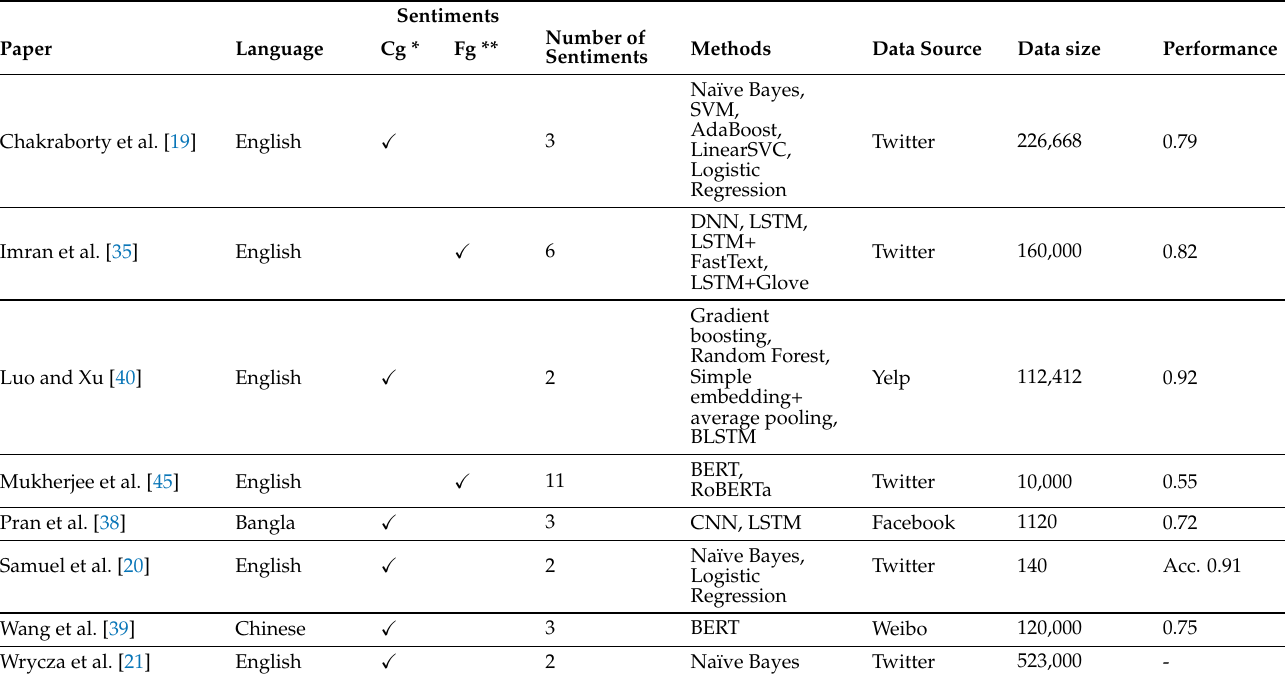
Table 1. Summary of the surveyed sentiment analysis systems in COVID-19 context (Performance refers to F1-score unless indicated